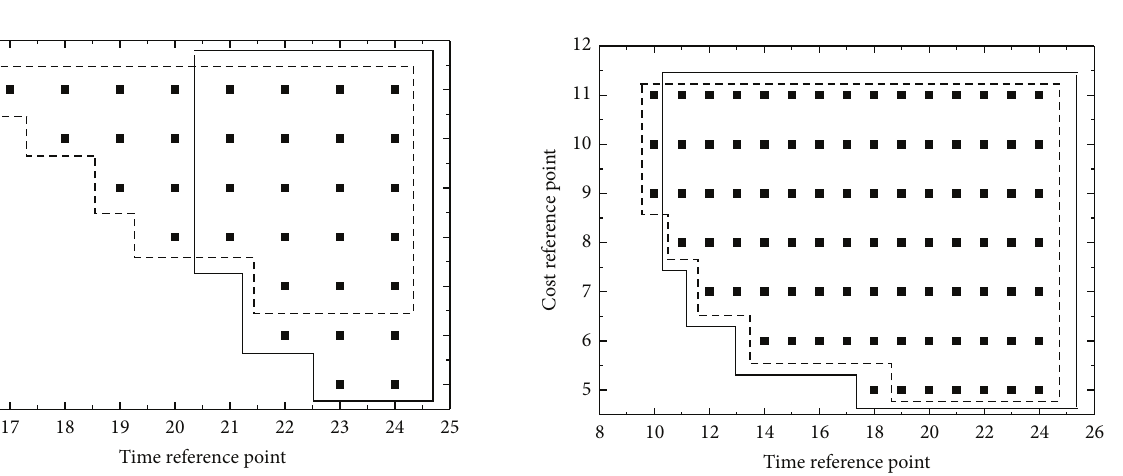
Figure 10: Possible reference points of carpooling success with traffic congestion rate 0.